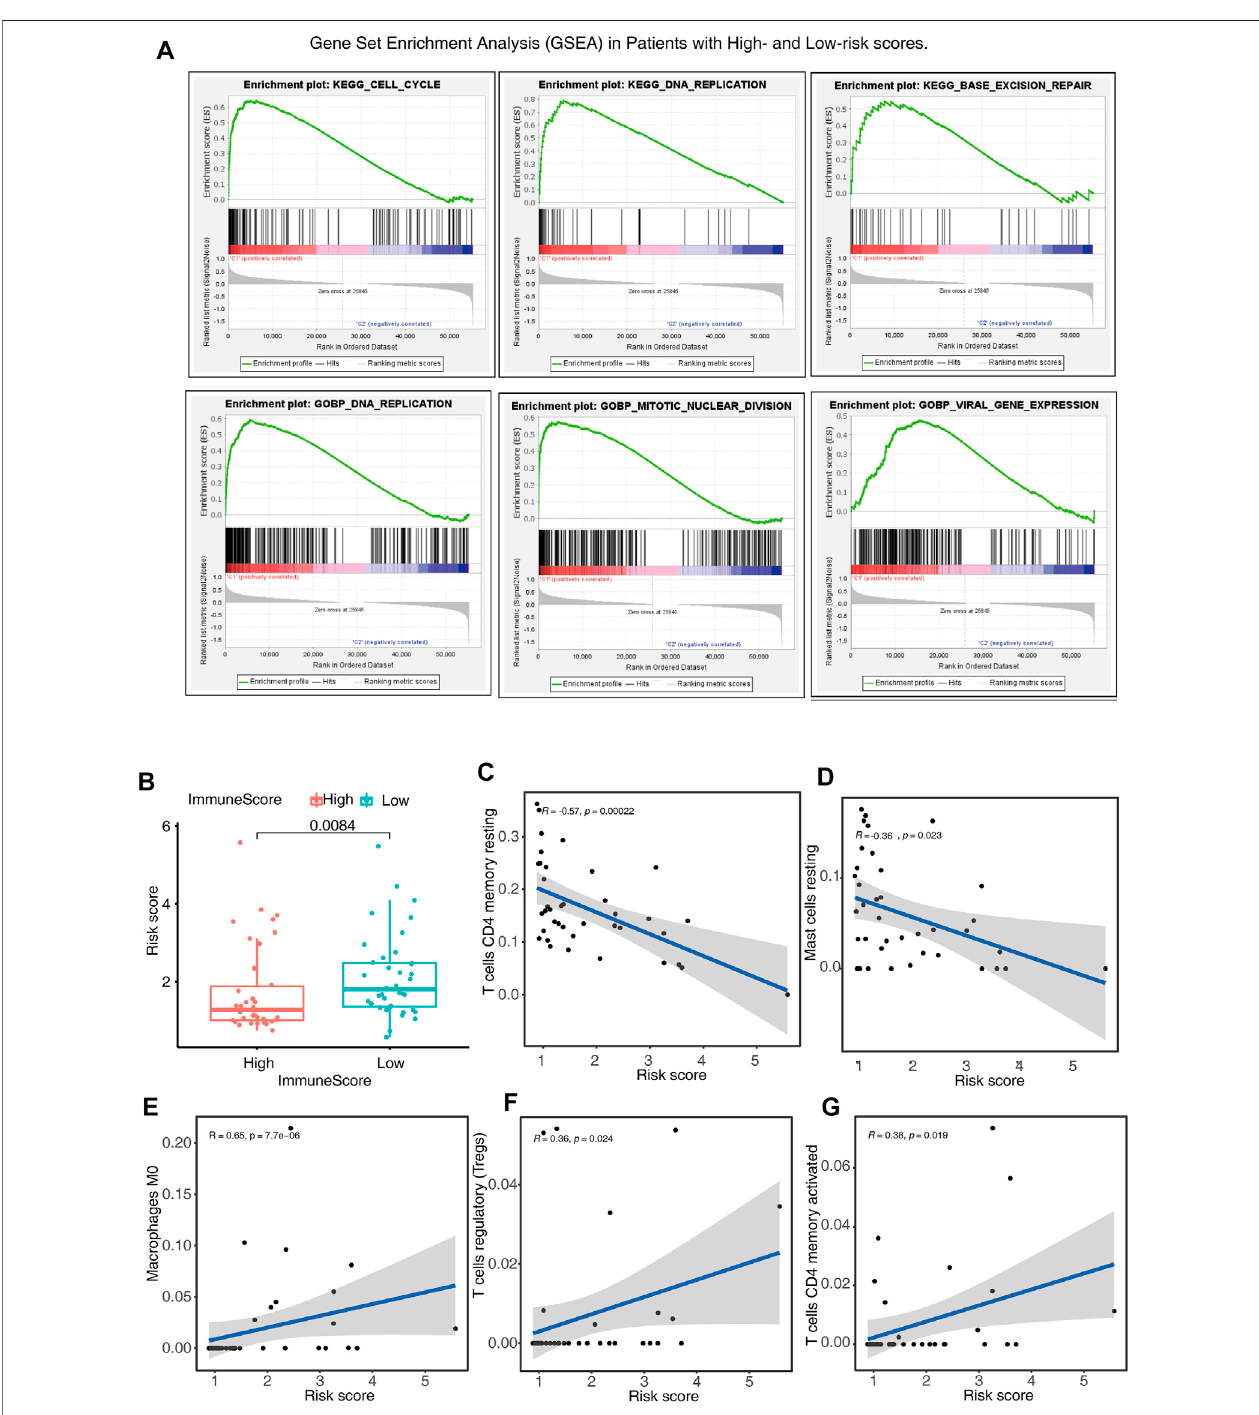
FIGURE 6 | Gene Set Enrichment Analysis (GSEA) and immune status in patients belonging to the high- and low-risk score cohorts. (A) GSEA indicates the enrichmentoftumorhallmarksinthehigh-riskcohort. (B) Boxplotsshowthedifferencesinriskscoresbetweenthepatientshavinglow-andhigh-immunescores. (C – G) The relationship between risk score and partial immune cell types in low- and high-risk cohorts.